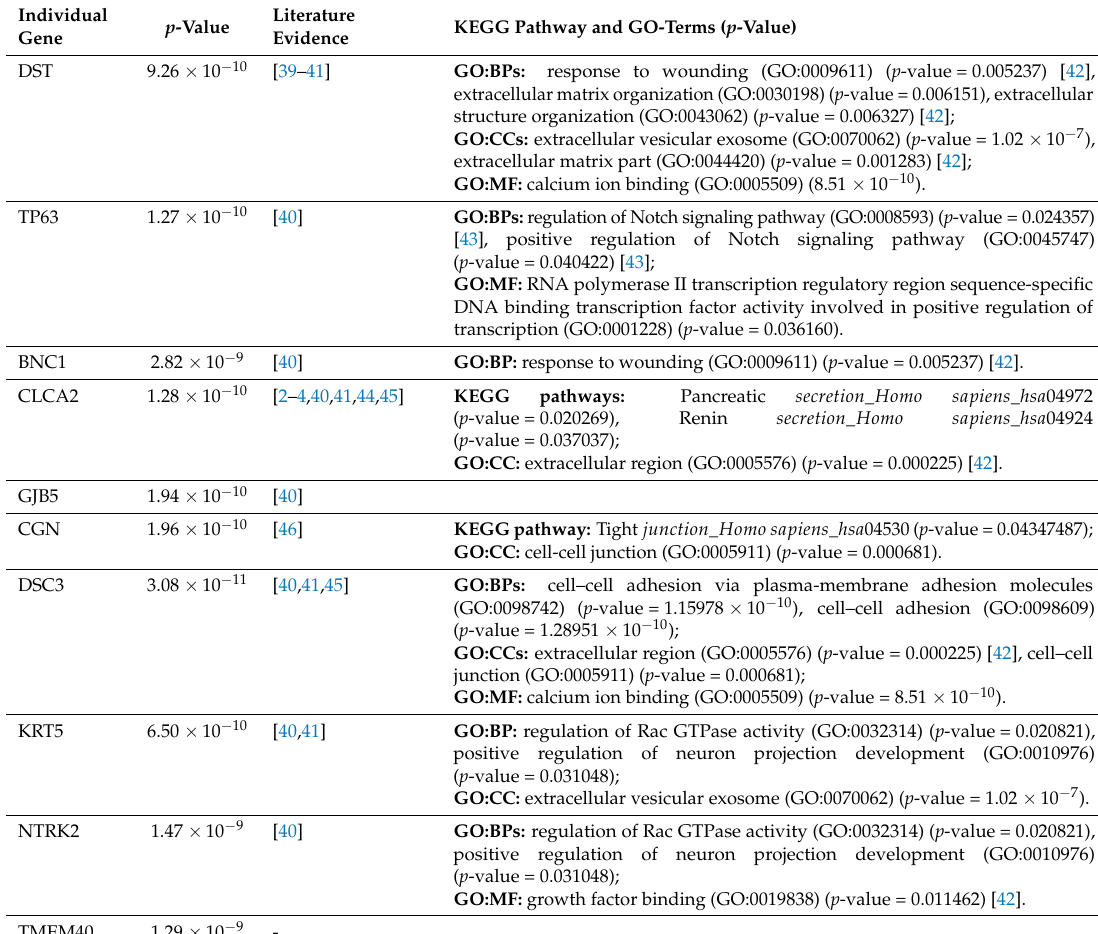
Table 2. Biological validations of individual genes belonging to the CGM s in Table 1 for the LUSC